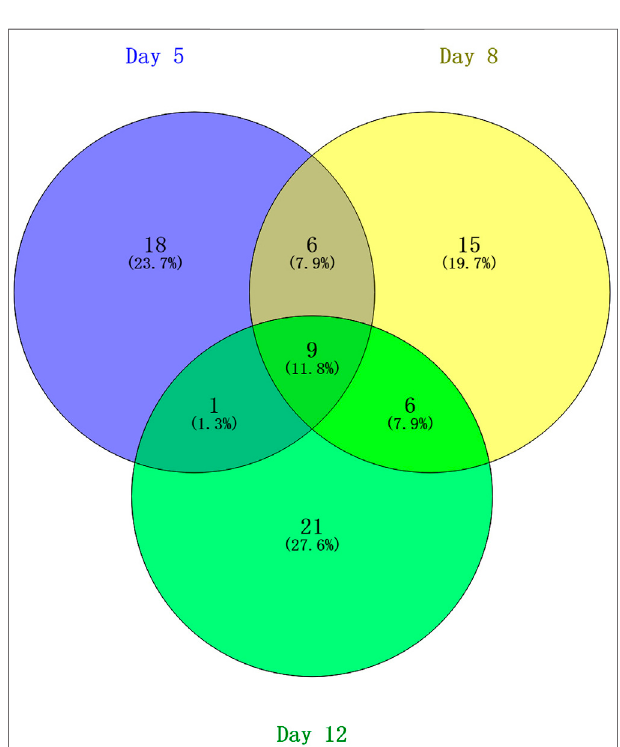
FIGURE3| Venndiagramofthedifferentialurinaryproteinsondays5,8, and 12 in EAU rats compared with control rats.